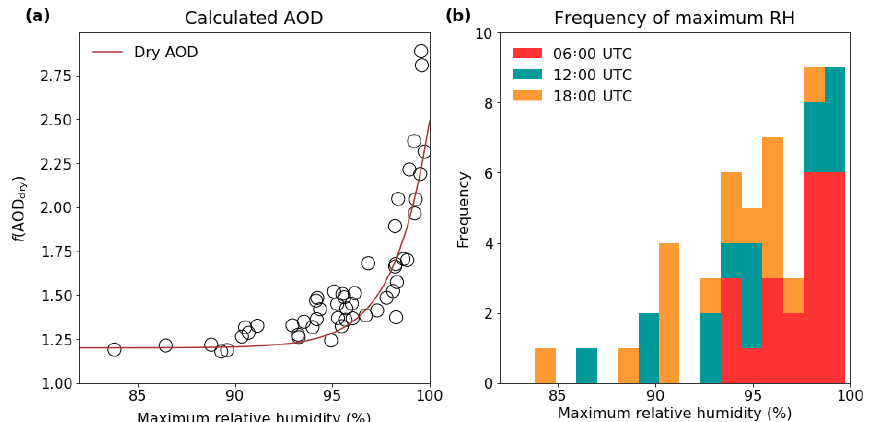
Figure 11. (a) The relationship between calculated AOD and the maximum sub-3km RH in a profile, and (b) the frequency distribution of maximum unsaturated sub-3km RH values. Bars in (b) are